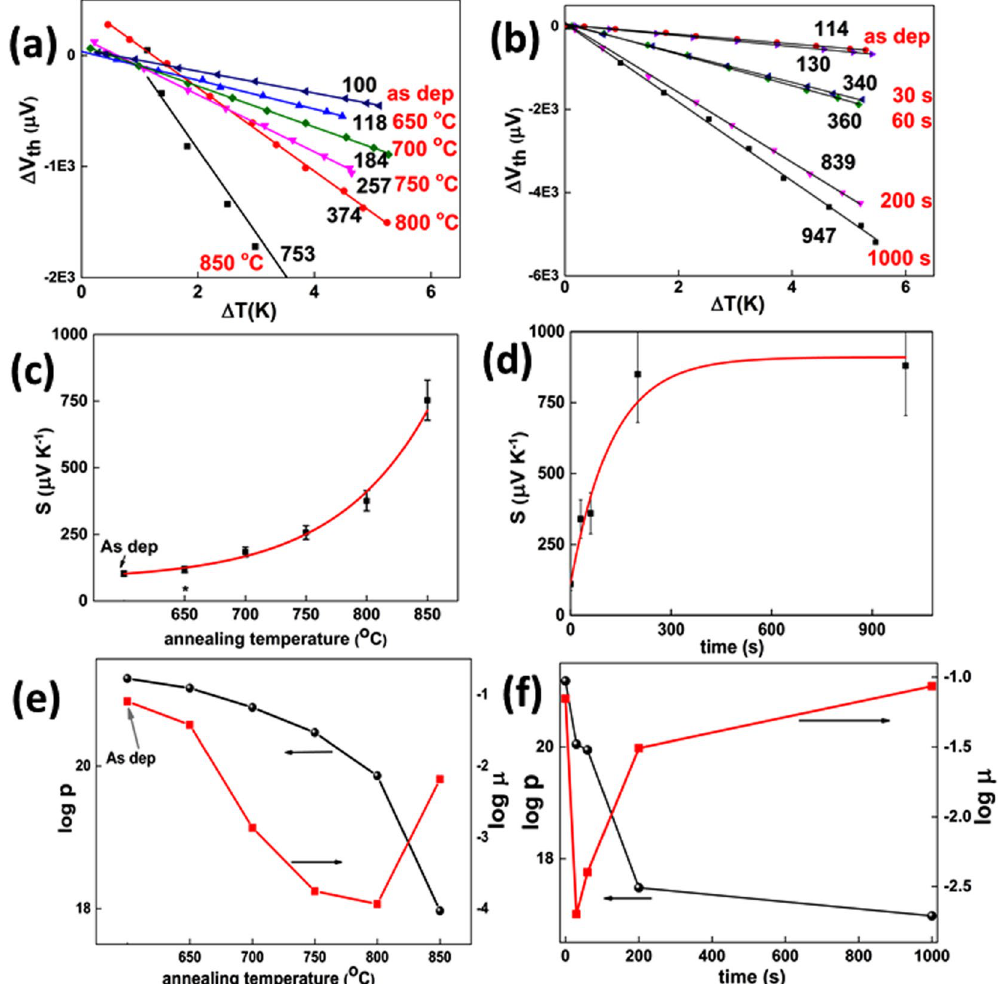
Figure 2. Seebeck coefficient measurement for Cu-Cr-O thin films (a) annealed at different temperatures; (b) annealed at 900 °C for various time intervals. Thermoelectric voltage Δ V th = V hot − V cold is measured as a function of the temperature gradient Δ T applied across the sample, with copper wire as reference. The measurement has been performed with the cold contact maintained at room temperature (23 °C). The values of the Seebeck coefficient S = −Δ V/ Δ T, determined from a linear fit, are indicated on the graph for each sample. The voltage offset is due to parasitic offsets from the measurement apparatus due to samples’ high resistance; (c) Seebeck coefficient vs annealing temperature; (d) Seebeck coefficient vs annealing time for thermal treatments at 900 °C. Red curves are corresponding to exponential fits; Logarithm of the carrier concentration (black) and of drift mobility (red) (e) as function of annealing time for samples annealed at a fixed temperature 900 °C; (f) as function of the annealing temperature for samples annealed for a fixed time t = 900